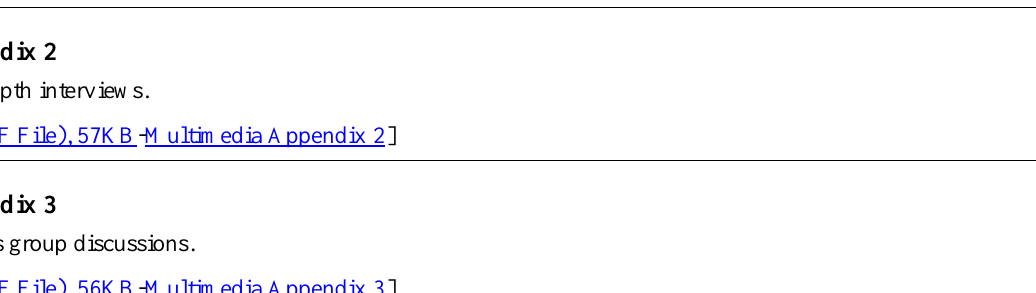
Table of Bhuasiri et al’s research framework with 3 main dimensions and subdimensions adapted to the setting of the medical licentiate